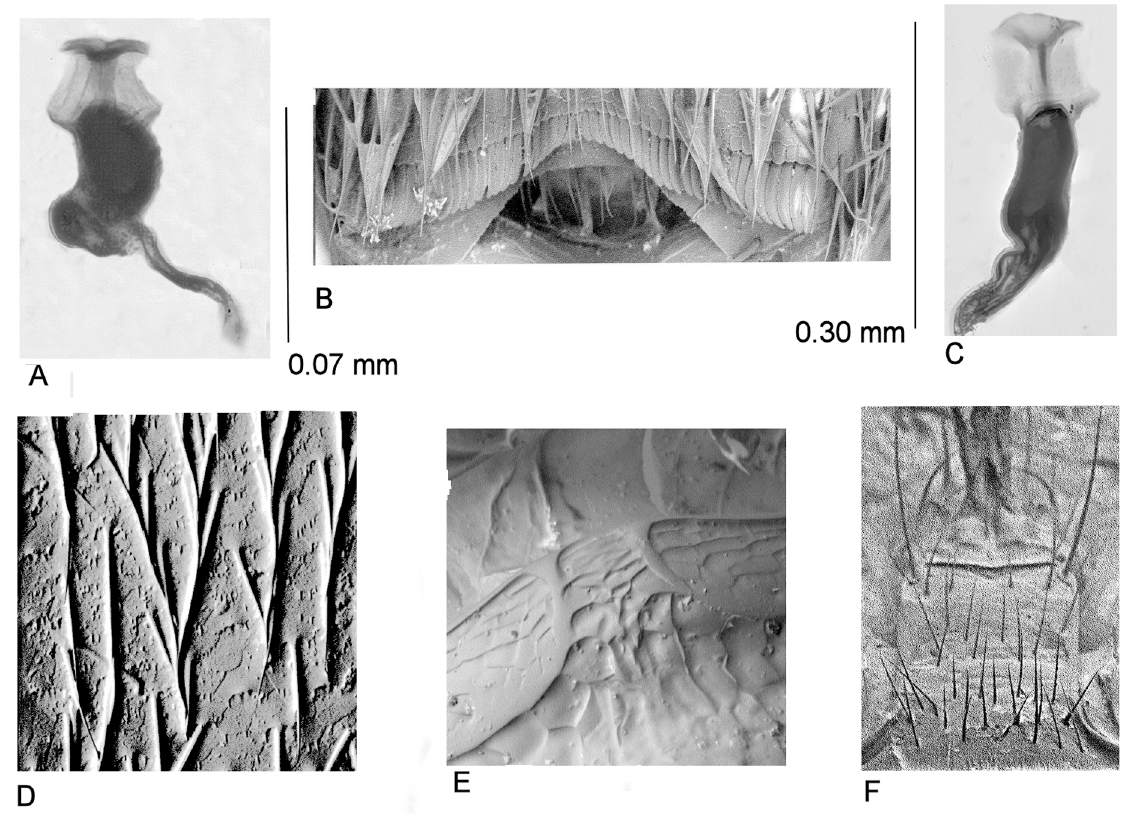
Fig. 17. A . Acrotrichus britteni Johnson, 1969, spermatheca. B . Acrotrichis cursitans Nietner, 1856, setae on ventrite VI ×1420. C . Acrotrichis agricola Darby, 2019, spermatheca. D . Acrotrichis cognata (Matthews, 1877), microtrichae on elytra ×1520. E . Baeocrara sp., medial portion of collar ×3150. F . Acrotrichis bubalis Darby, 2019, setae on submentum